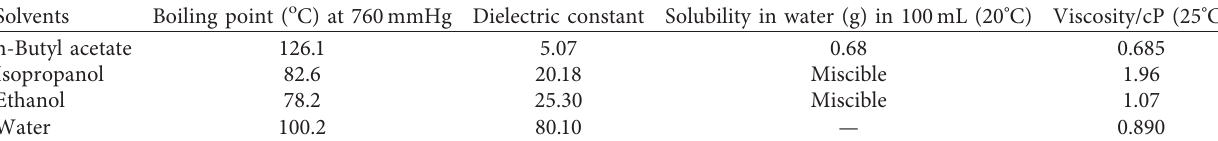
Table 1: Physical properties of the